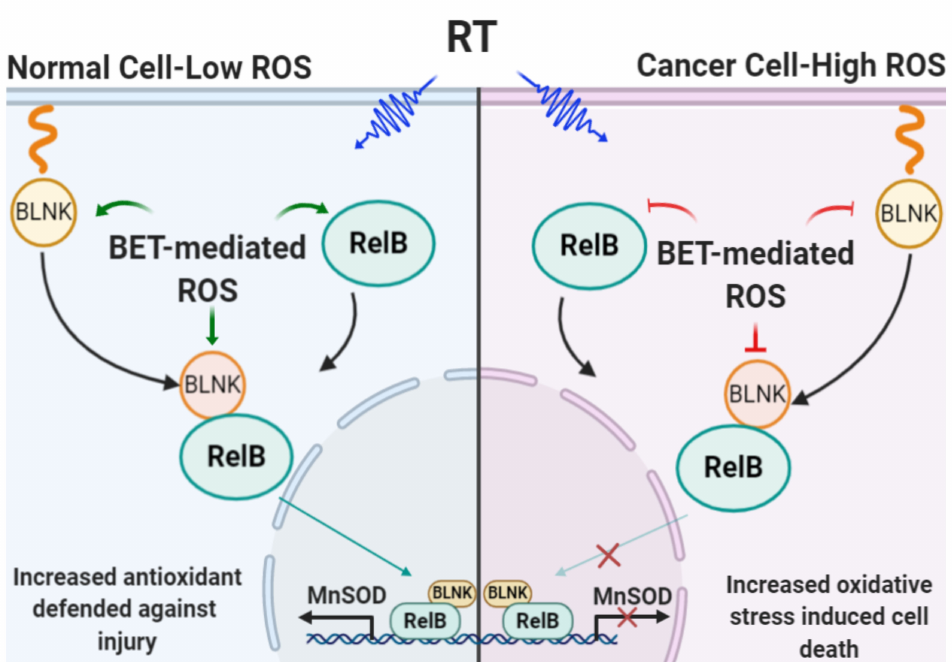
Figure 8. Schematic of how BET-mediated ROS production sensitizes PCa cells toward death caused by RT while protecting non-PCa cells against injury from RT off-target effects. Aberrant redox homeostasis of cancer cells enables redox-modifying agent BET to enhance radiation therapy efficacy by selective sensitization. In normal cells under physiologic conditions, cellular redox status is kept at a low oxidizing level. A shift in cell redox status toward an oxidizing condition, from BET + RT, will stimulate the expression of RelB-BLNK and translocation to the nucleus, which leads to upregulation of the antioxidant system, including MnSOD. The upregulation of MnSOD maintains redox status in normal cells and promotes cell survival. To the contrary, cancer cells are usually under high oxidizing conditions. A comparable shift in ROS levels modulated by BET + RT to an extreme oxidizing condition will cause cell death. Green arrows = activation; Red line =